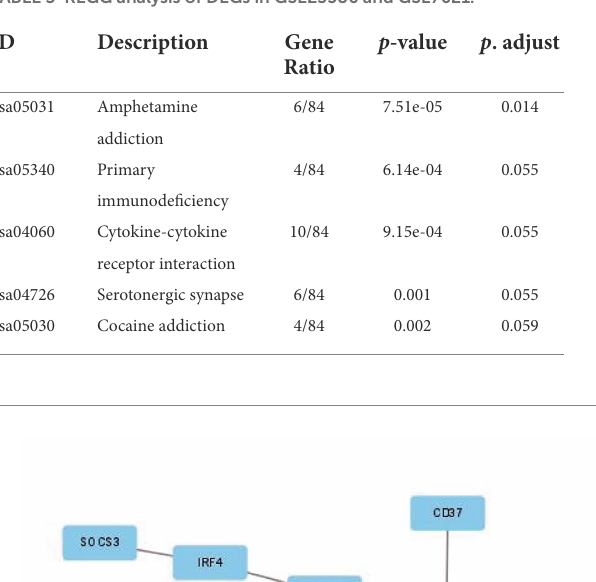
TABLE 3 KEGG analysis of DEGs in GSE23586 and GSE7621.